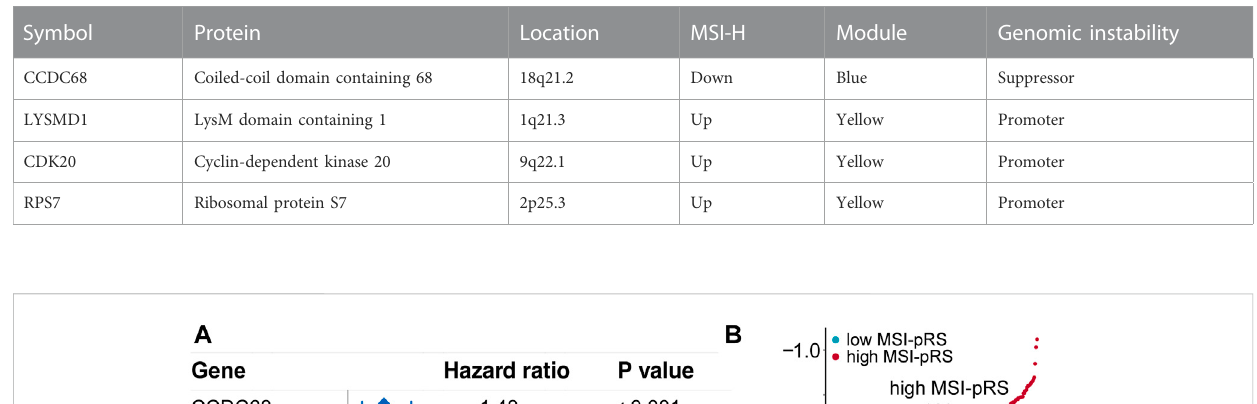
TABLE 1 Details of genes used for the construction of the MSI-related prognostic risk score (MSI-PRS).